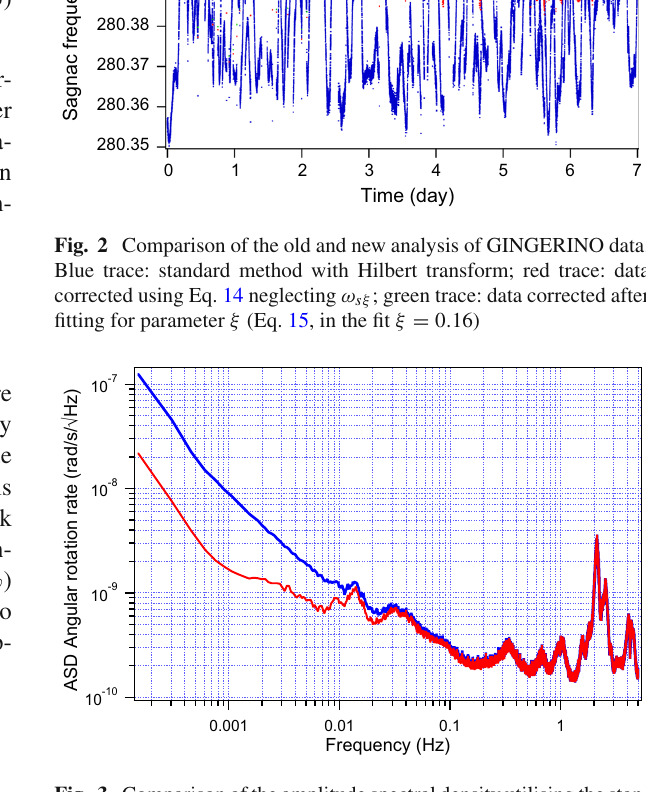
Fig. 3 Comparison of the amplitude spectral density utilising the stan- dard (blue data) and new analysis (red data). The two ASD are